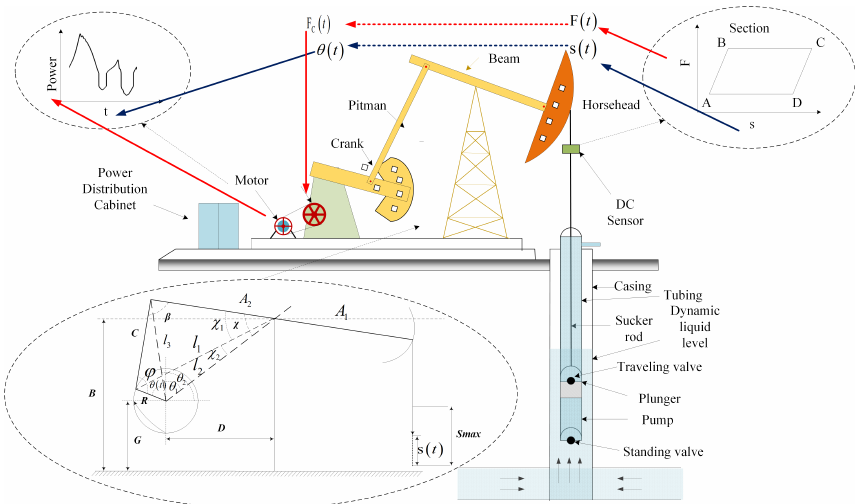
Figure 1. Sucker rod pump